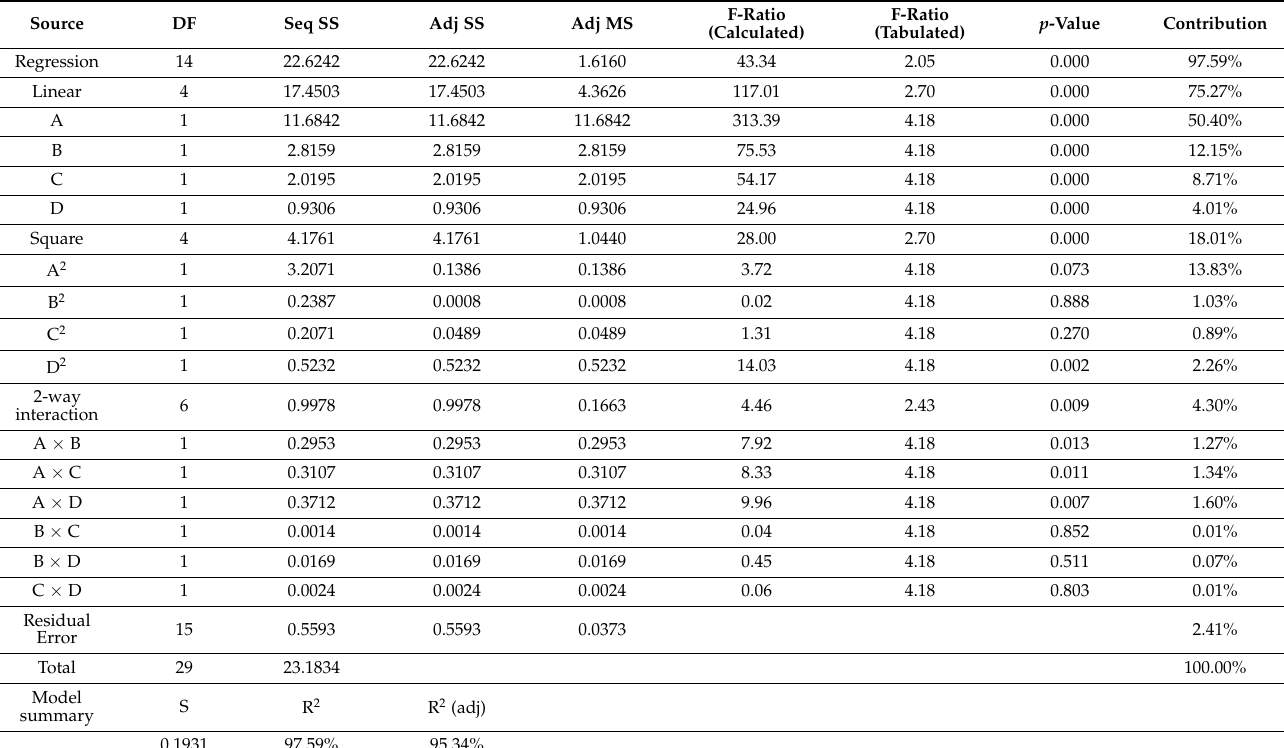
Table 12. ANOVA for surface roughness of MoS 2 -loaded